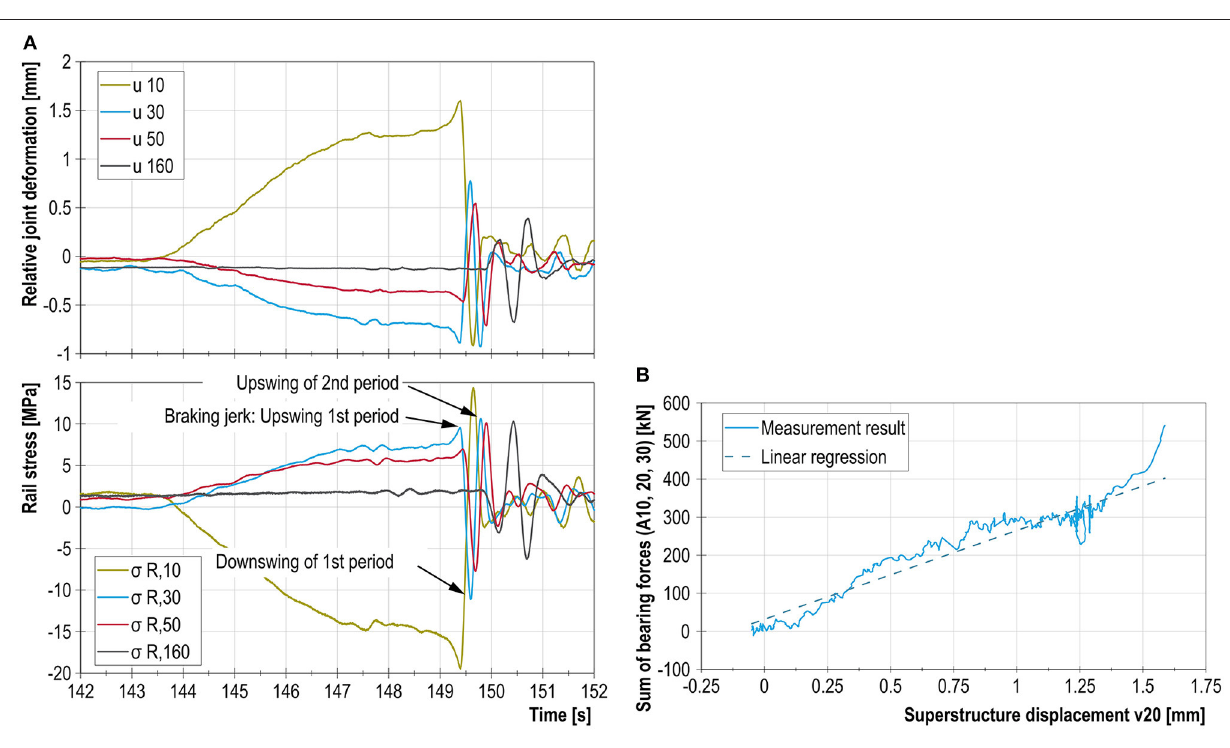
FIGURE 14 | (A) Development of the longitudinal deformation of the bridge and the rail stresses at the joints over time. (B) Sum of the horizontal forces in the substructure of superstructure segment A10–30 vs. horizontal deformation of the